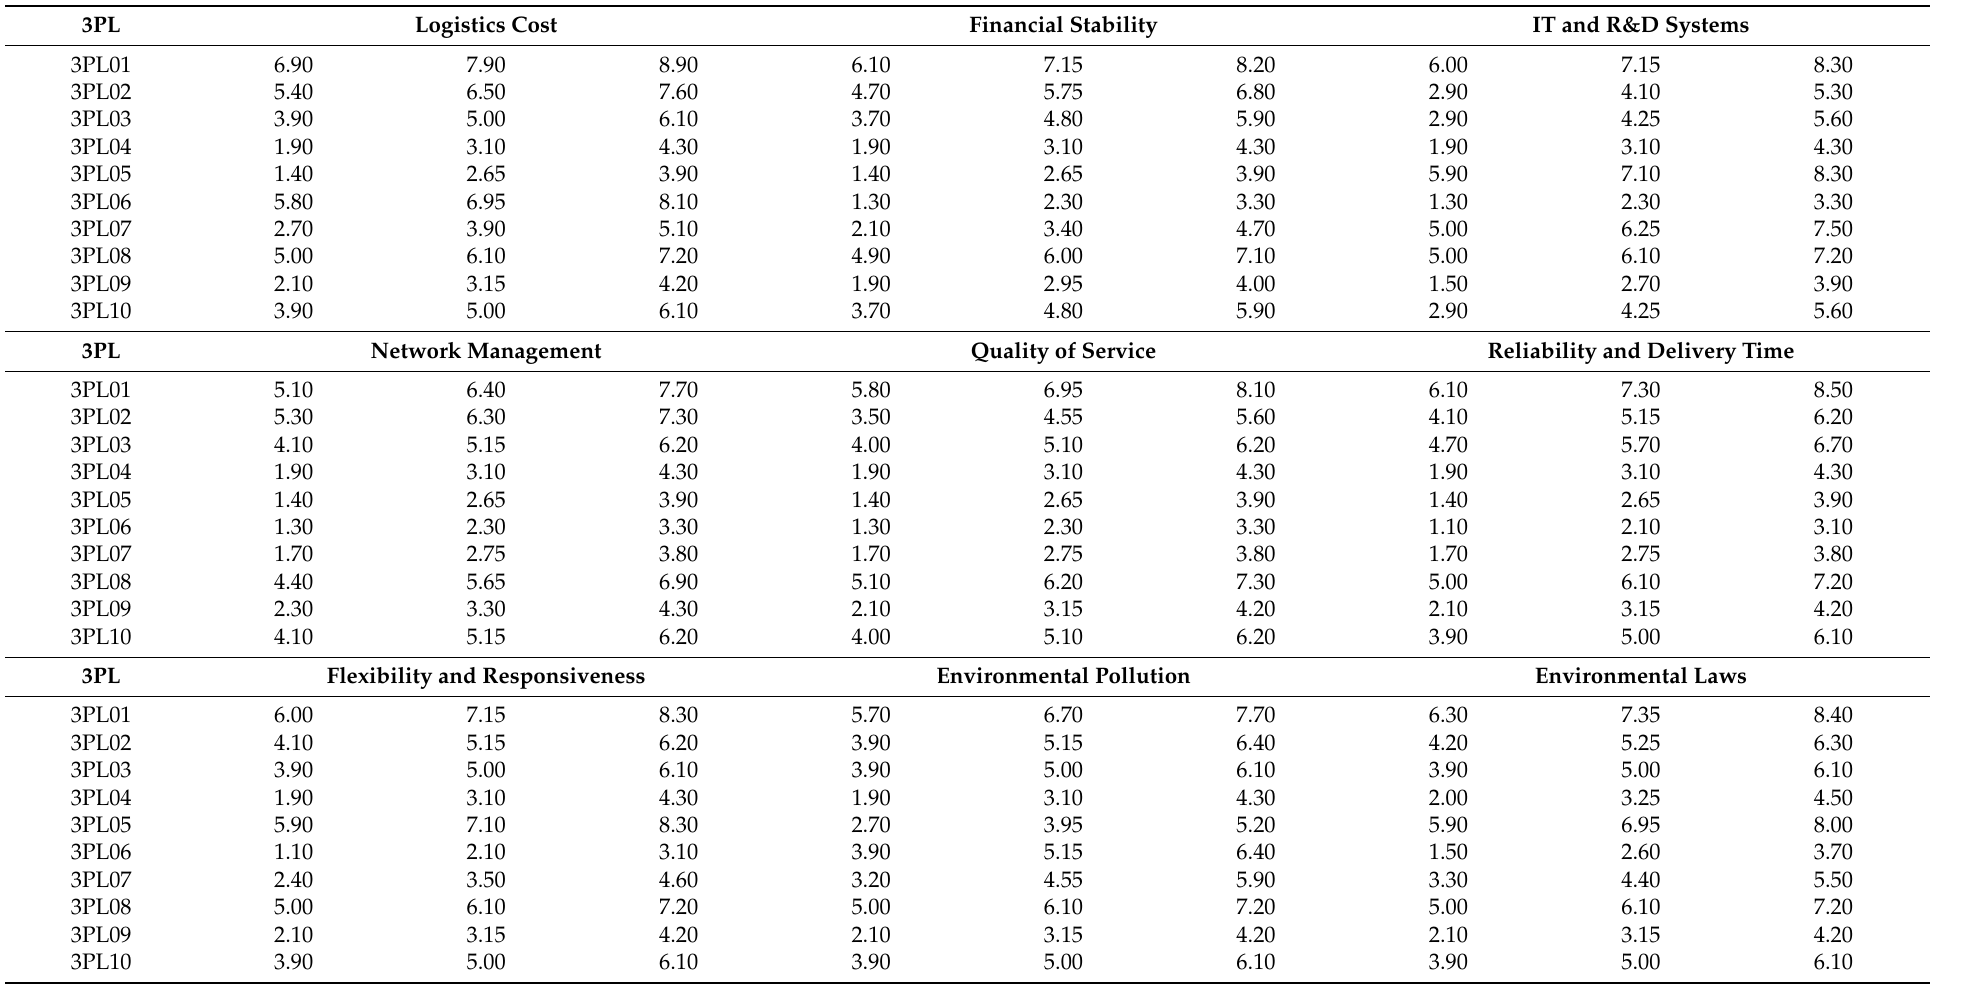
Table A2. The aggregated fuzzy decision matrix of FVIKOR